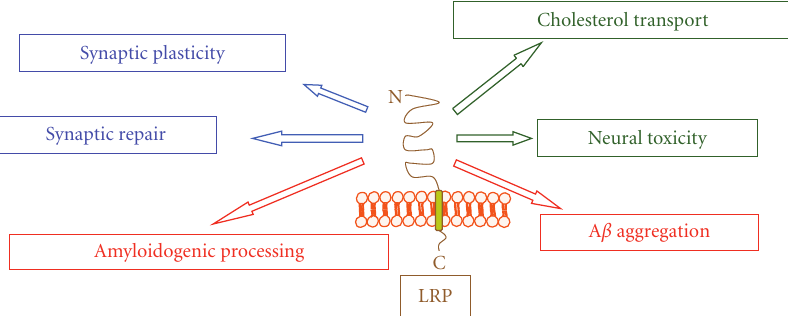
Figure 3: Role of LPR8 activation in normal brain functioning and in neurodegeneration during AD. In the figure are indicated the di ff erent roles in which LRP8 transmembrane protein is involved, in the healthy brain and AD